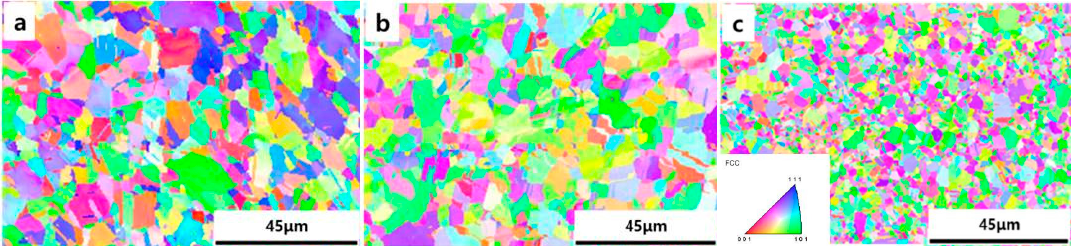
Figure 2. Electron back-scattering diffraction (EBSD) inverse-pole-figure maps of annealed